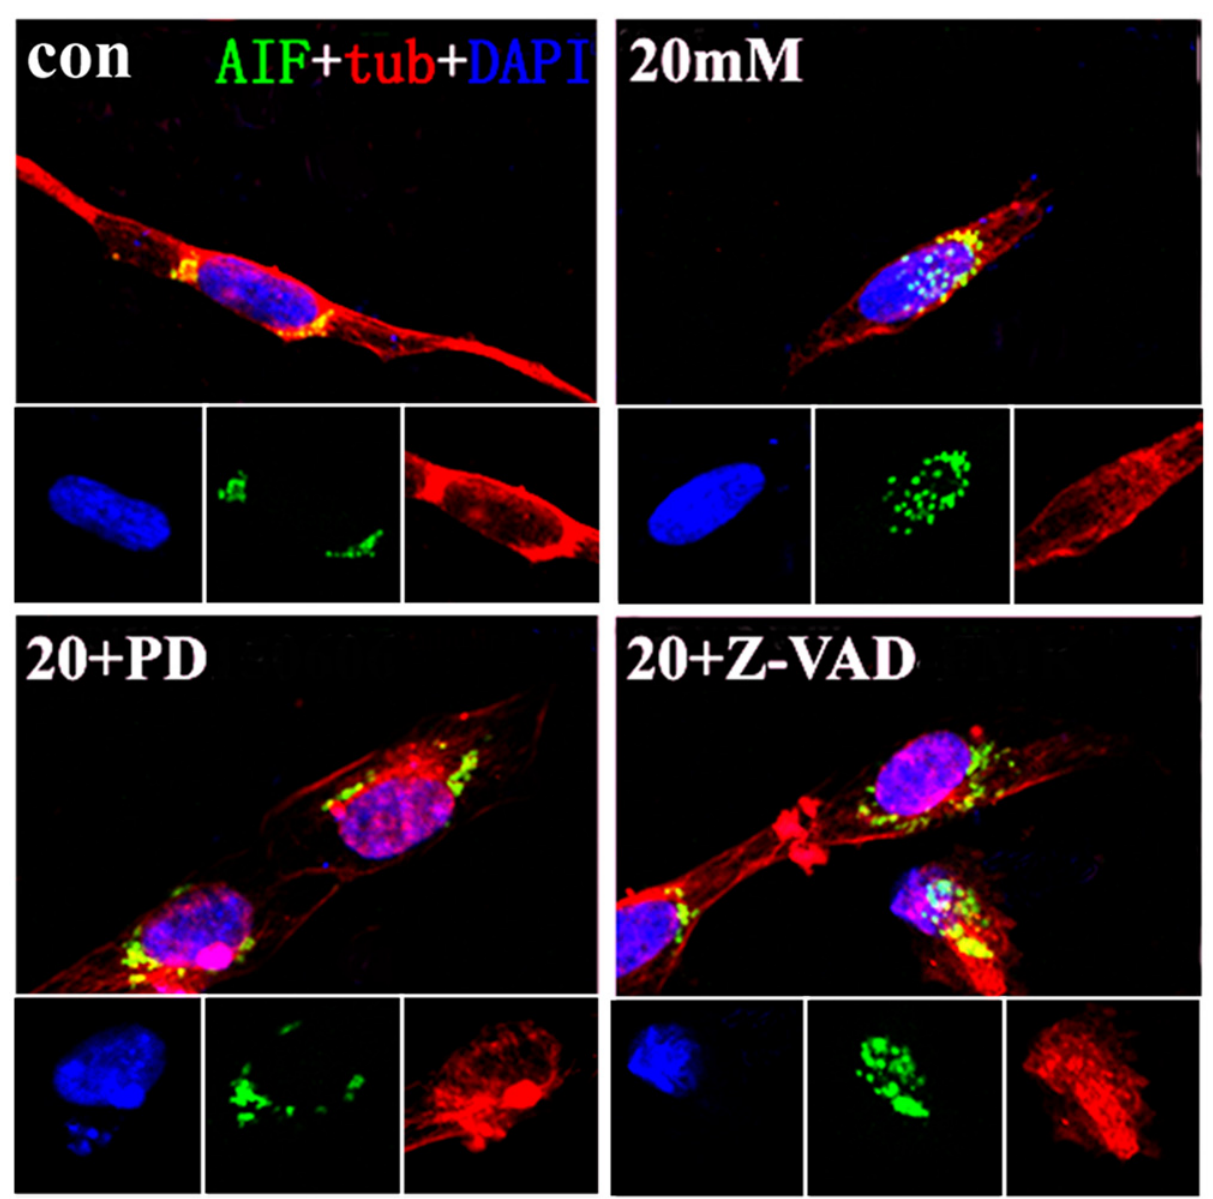
Fig 3. Immunofluorescence staining of SGNs in different interventions. Immunofluorescence staining in cultured SGNs. (A) (B) (C) (D) were treated as previously described in Fig 2. The AIF staining was distributed in the cytoplasm of the SGNs in the normal condition. Clear translocation into the nuclei of AIF was observed in the 20 mM Glu-treated and 20 mM Glu+Z-VAD-FMK-treated groups. No translocation was observed in the 20 mM Glu+PD150606-treated group. Scale bar = 20 μ